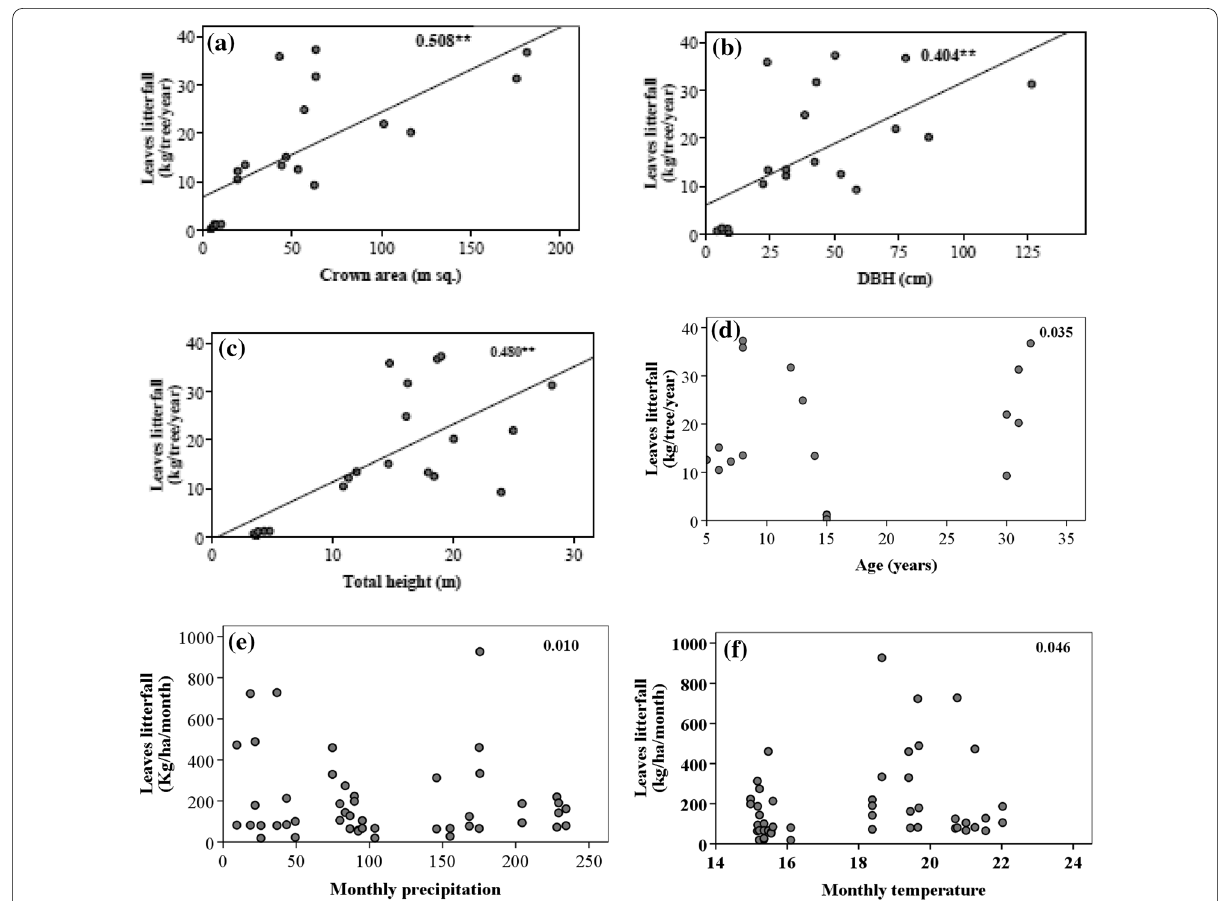
Fig. 5 a-f; 5. Relationships of leaves litterfall amounts with a crown area, b DBH, c total heught, d age, e precipitation, and f temperature. Numbers in each graph are coefficients of determination (R 2 values), trend lines are shown for significant relationships only. ** p < 0.05, **p <